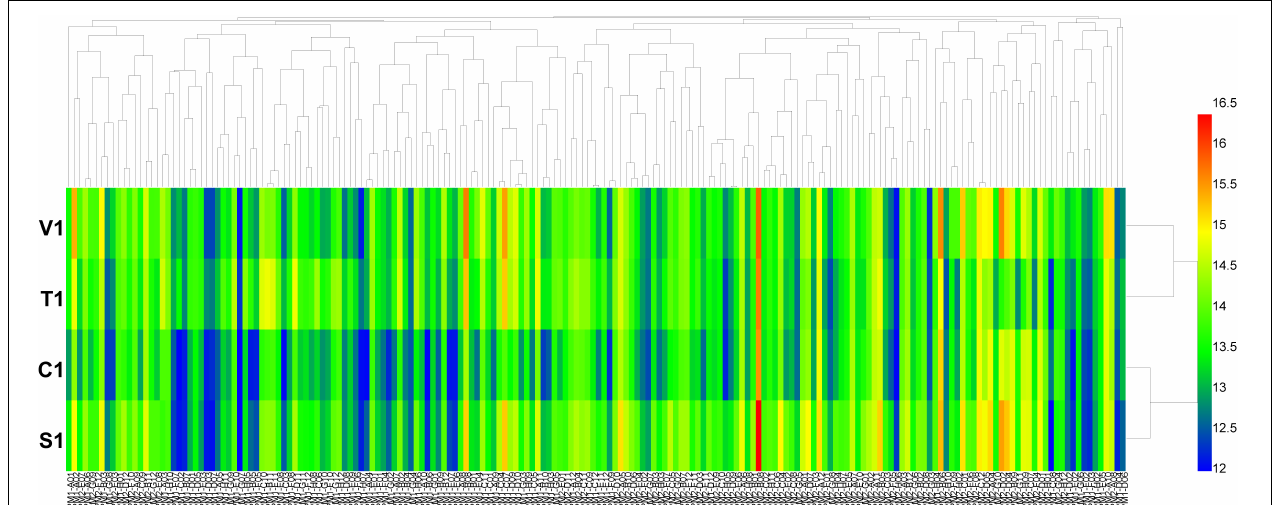
FIGURE 1 | Overview of metabolic phenotypes of four isolates of Botrytis cinerea on 190 carbon (C) sources tested. V1, T1, C1, and S1 were the isolates of B. cinerea from tomato, tobacco, cucumber, and strawberry, respectively. Heatmap of maximum area values of 190 C sources expressed as maximum curve area monitored during 96 h of incubation. The legend of color code from blue to green, and red shades indicate low, moderate, and high utilization of C sources, respectively, assessed as arbitrary Omnilog values.